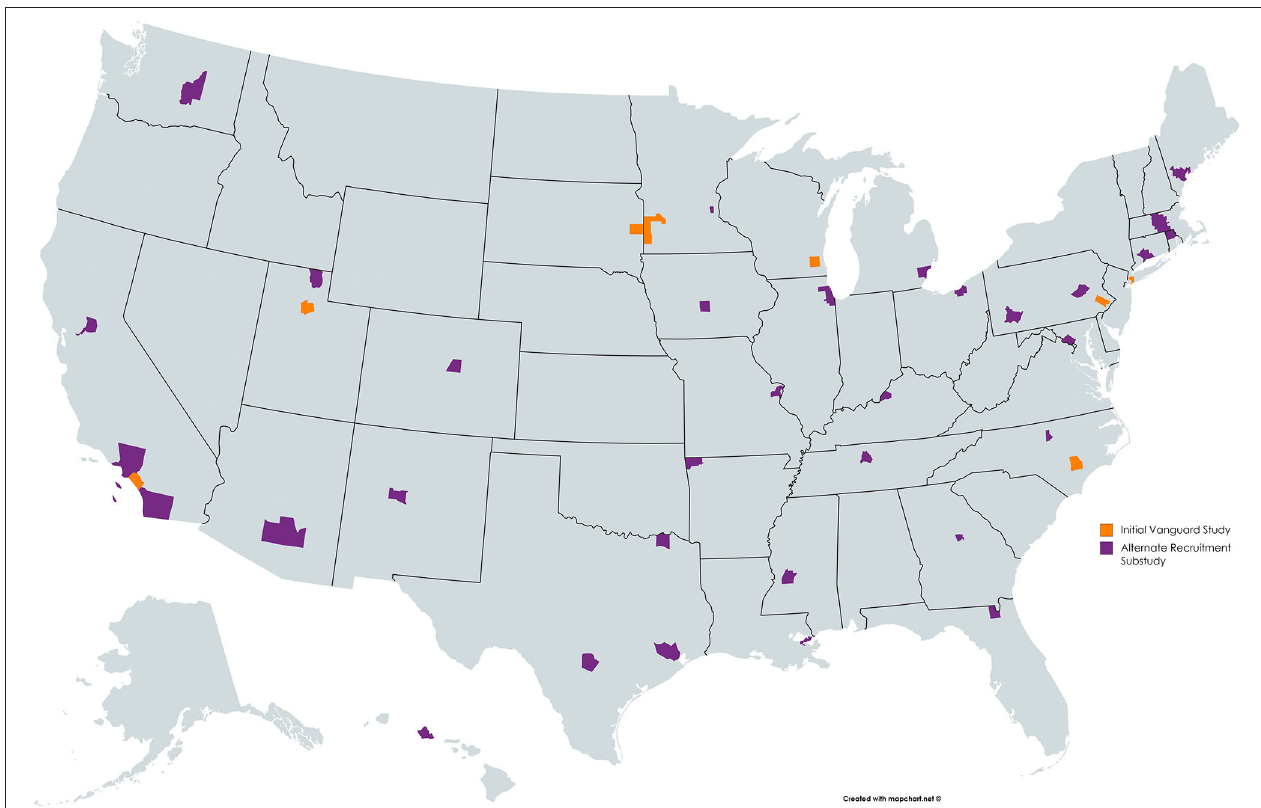
FIGURE 2 | NCS participating counties by recruitment strategy across the United